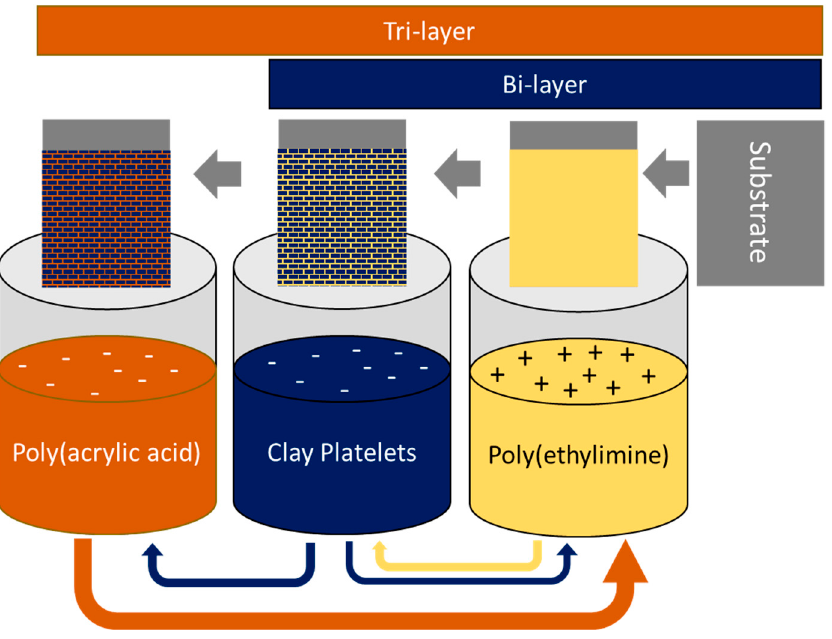
Figure 7. Layer-by-layer deposition process for bi- and tri-layer systems with the alternate adsorption of charged polymer and nanoclay platelets. Adapted from [99].